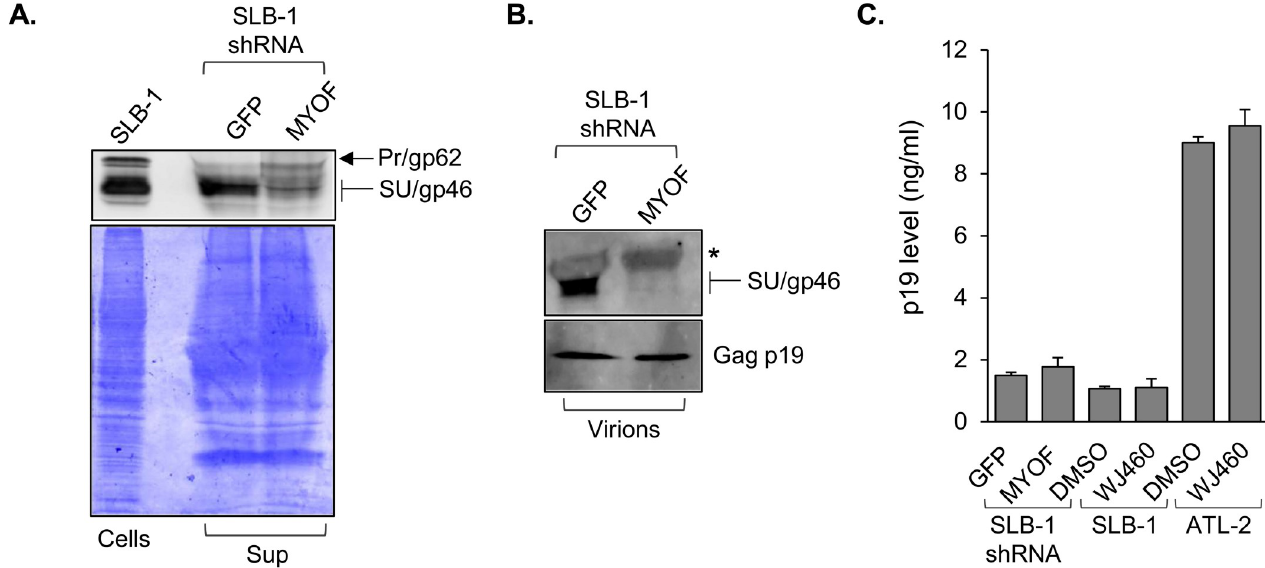
Fig 9. MyoF increases levels of total extracellular and virion-associated SU (gp46). (A) Knockdown of MyoF expression reduces overall levels of SU in the culture medium of HTLV-1 cells. TCA-precipitated proteins from culture media of SLB-1 cells stably transfected with shRNA targeting GFP or MYOF mRNA were divided into equal fractions and analyzed by Western blot using an antibody against SU/Pr (upper panel) and, separately, by Coomassie blue-staining following SDS-PAGE (lower panel). Whole cell extract from SLB-1 cells served as a positive control. (B) Knockdown of MyoF expression reduces levels of SU in cell-free HTLV-1 virions. Culture media from SLB-1 cells stably expressing an shRNA targeting GFP or MYOF mRNA were filtered, ultracentrifuged and analyzed by Western blot using antibodies against SU/gp46 and Gag p19; � denotes a nonspecific band from the serum. (C) Knockdown or inhibition of MyoF does not affect levels of virus released from the cells. Clarified culture media from SLB-1 cells stably expressing an shRNA targeting GFP or MYOF mRNA and SLB-1 and ATL-2 cells treated with DMSO or 1 μ M WJ460 for 24 h were analyzed by ELISA to quantify levels of Gag p19. The graph shows values averaged from three